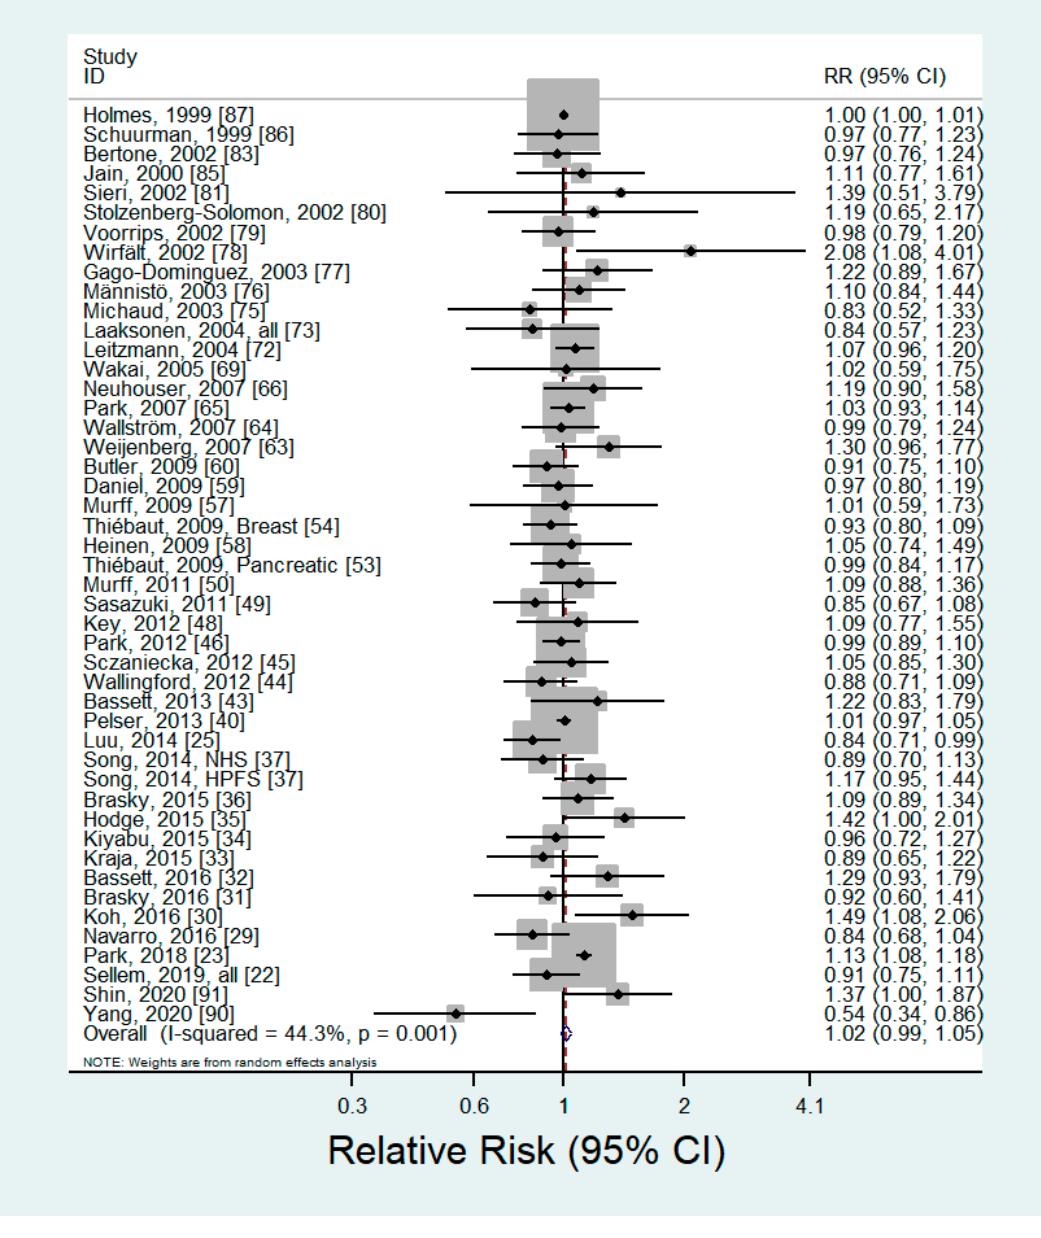
Figure 1. Forest plot of prospective studies of cancer for the highest versus lowest category of n-6 PUFA intake, using a random-e ff ects